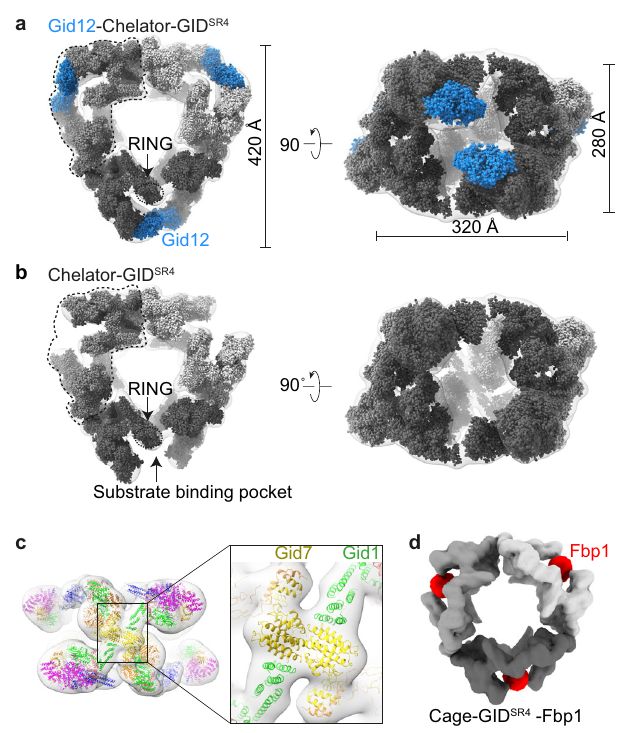
Fig. 5 Cryo-EM maps of a ≈ 5 MDa 60-subunit Cage-GID SR4 assembly. a Overall architecture of Gid12-Cage-GID SR4 is seen from its transparent cryo-EM density fi t with three copies of models of Gid12-Chelator-GID SR4 in solid surfaces in different shades of gray, with models for Gid12 (this study) in blue. b 19.8 Å-resolution cryo-EM density for Cage-GID SR4 is shown as a transparent surface fi t with three copies of models of Chelator- GID SR4 (EMD-12541) in solid surfaces in different shades of gray. c Models of Gid1 and Gid7 domains fi tted at junctions of the three individual Chelator-GIDs. These interaction at the junction constitute the cage architecture. The resolution of the density, together with prior maps and models, allows attributing domains but not their speci fi c orientations or interactions. d 12 Å-resolution cryo-EM density map of Cage-GID SR4 -Fbp1 (here, the N-terminal degron of Fbp1 - PTLVNG was exchanged with Mdh2 degron - PHSVTP to increase stability). Fbp1 tetramer encapsulated in the oval center of each Chelator-GID SR4 is color-coded in